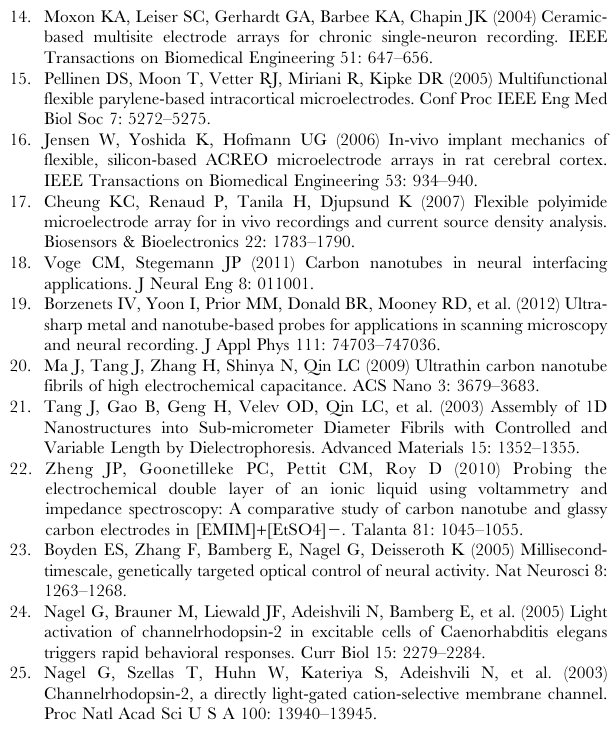
Figure S1 Electrochemical impedance spectroscopy (EIS) of CNT probe with the conformal Parylene-C